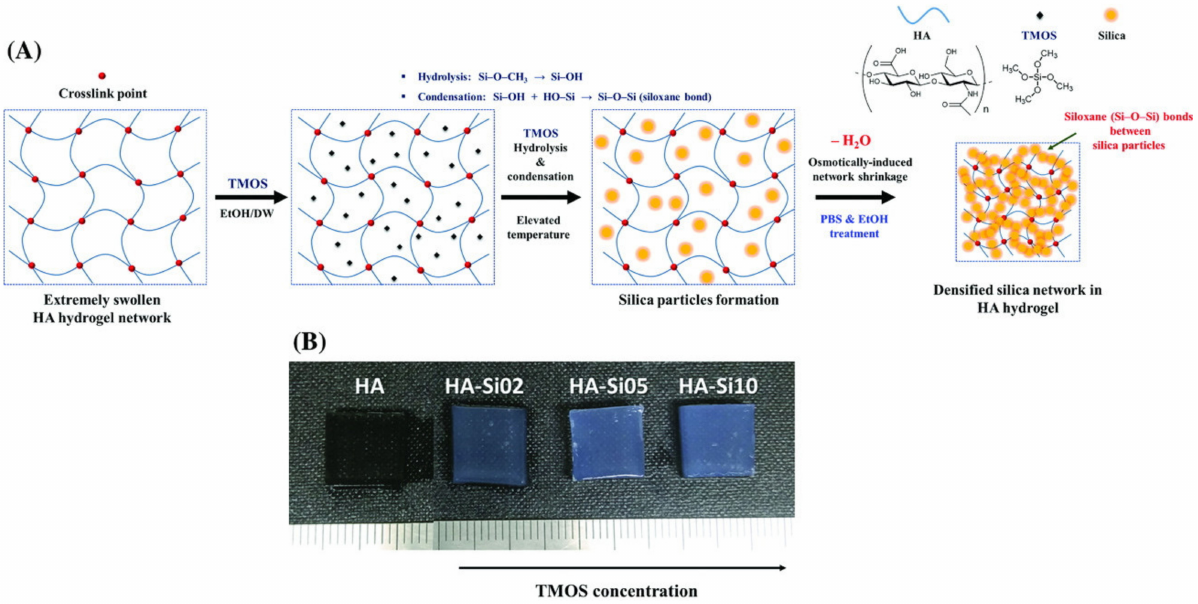
Figure 7. ( A ) Schematic illustration of the fabrication and ( B ) an optical image of HYH–silica nanohybrid hydrogels. Reproduced with permission [106]. Copyright Wiley,